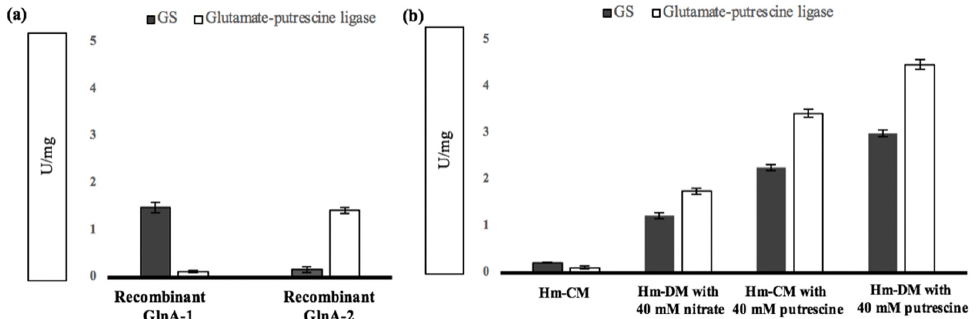
Figure 6. Assays for GlnA specific activity. ( a ) GS activity and glutamate–putrescine ligase activity in the recombinant proteins. ( b ) GS activity and glutamate–putrescine ligase activity depending on the nitrogen